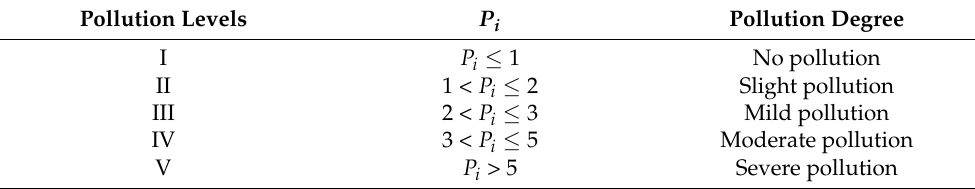
Table 2. Standard for the single-factor pollution